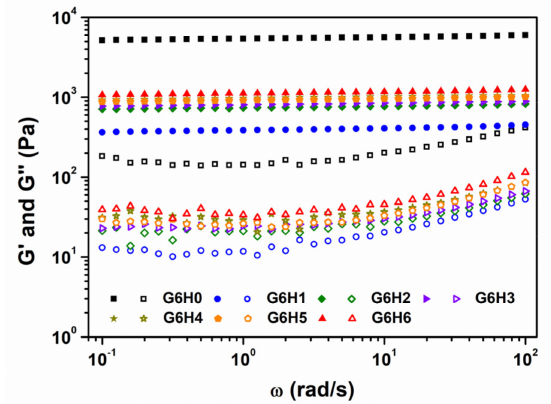
Figure 6. Storage modulus (G (cid:48) ) and loss modulus (G (cid:48)(cid:48) ) variation as a function of frequency for GA and GA/HPMC mixed gels at 25 ◦ C. The closed and open symbols correspond to G (cid:48) and G (cid:48)(cid:48) ,